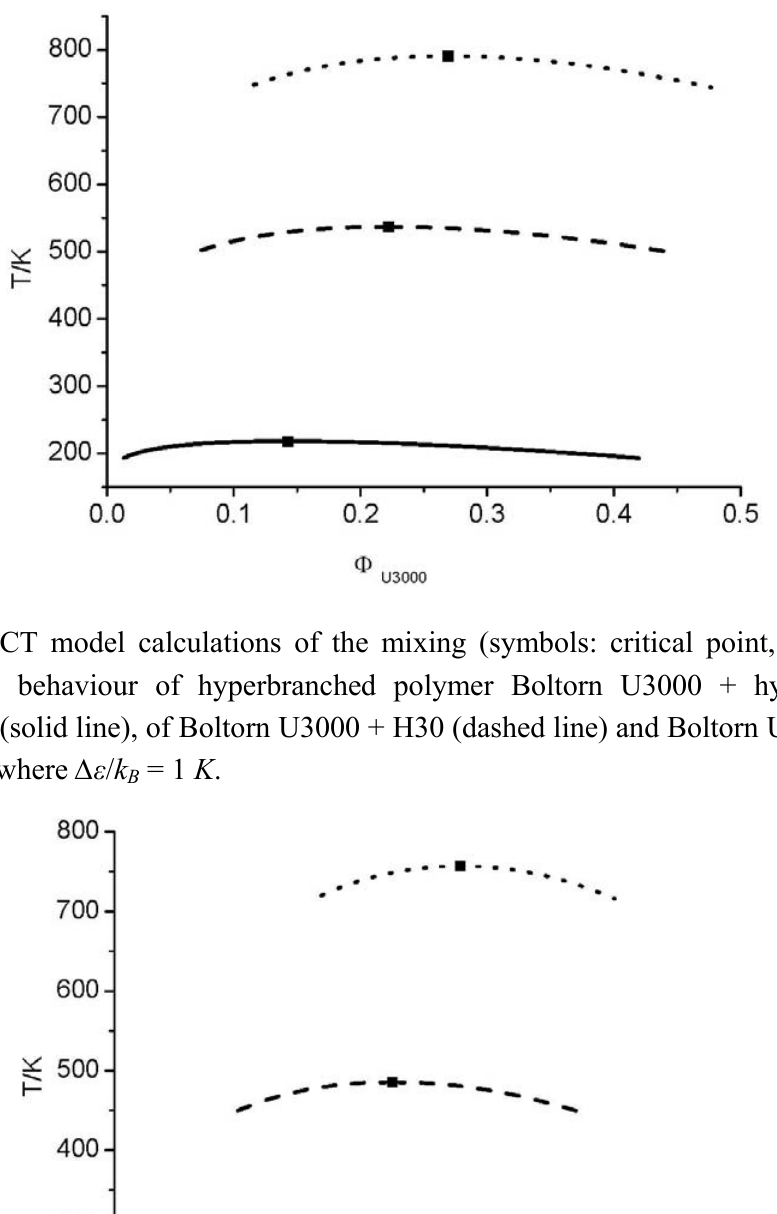
= 10, dashed line: M = 30, dotted line: 2 2